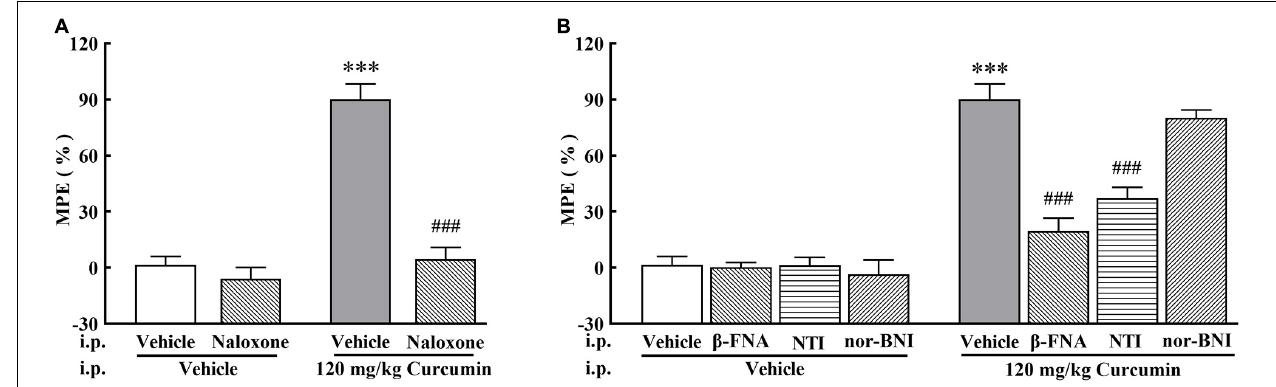
FIGURE 2 | Effect of pretreatment with opioid receptor antagonists on the anti-allodynia activity of curcumin in cancer-induced bone pain mice. Mice were treated with curcumin (120 mg/kg, i.p.) twice a day for 11 days after the injection of B16-F10 melanoma cells (1 × 10 5 , 5 µ l). In the 11th day, The opioid antagonists naloxone (1 mg/kg, i.p.) (A) , NTI (0.5 mg/kg, i.p.), β -FNA (0.5 mg/kg, i.p.), and nor-BNI (0.5 mg/kg, i.p.). (B) were administered at 10 min, 10 min, 4 h, and 30 min prior to curcumin (120 mg/kg, i.p.) injection, respectively. MPE% induced by curcumin (120 mg/kg, i.p.) 4 h after administration was evaluated. Data are shown as